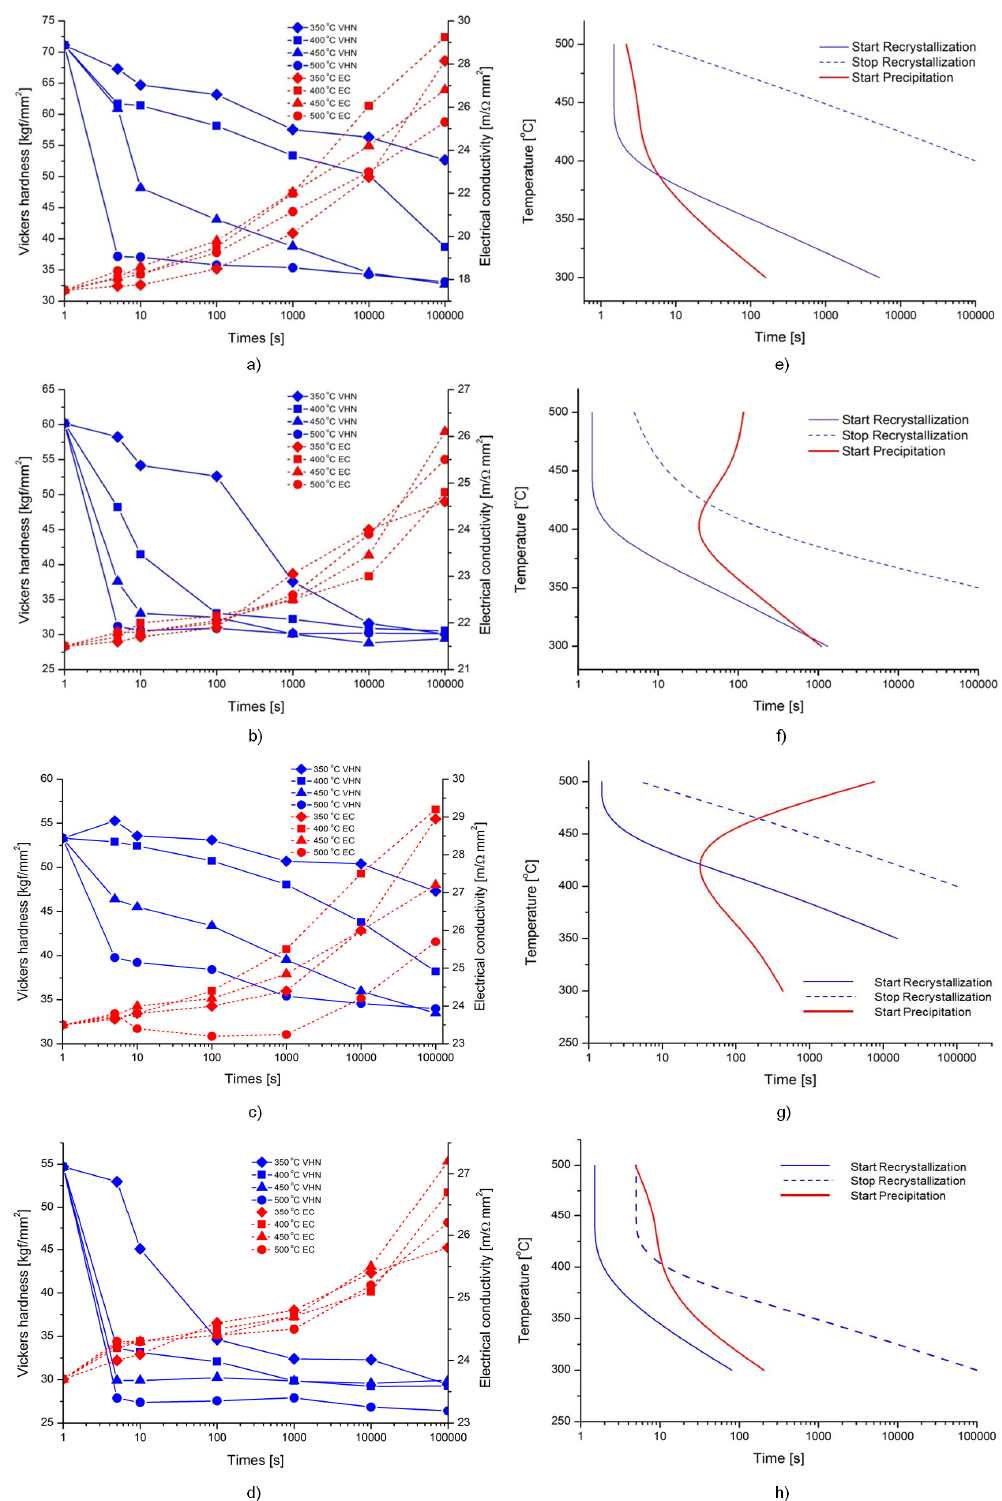
Figure 6. ( a ) Vickers hardness and electrical conductivity (EC) for the different materials material with the true strain of ε = 1.6 during isothermal back annealing at 350 °C, 400 °C, 450 °C and 500 °C for different times ( a – d ) and TTT ‐ diagrams ( e – g ) for: C2 ‐ 0 ( a , e ); C2 ‐ 1 ( b *, f ); C2 ‐ 2 ( c *, g ); and C2 ‐ 3 ( d , h ). * [30] Copyright 2012 by The Minerals, Metals and Materials Society, reprinted with permission.